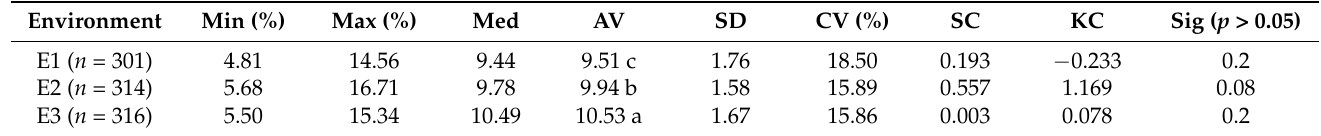
Table 2. The statistical analysis of total protein contents among different accessions of foxtail millet in three